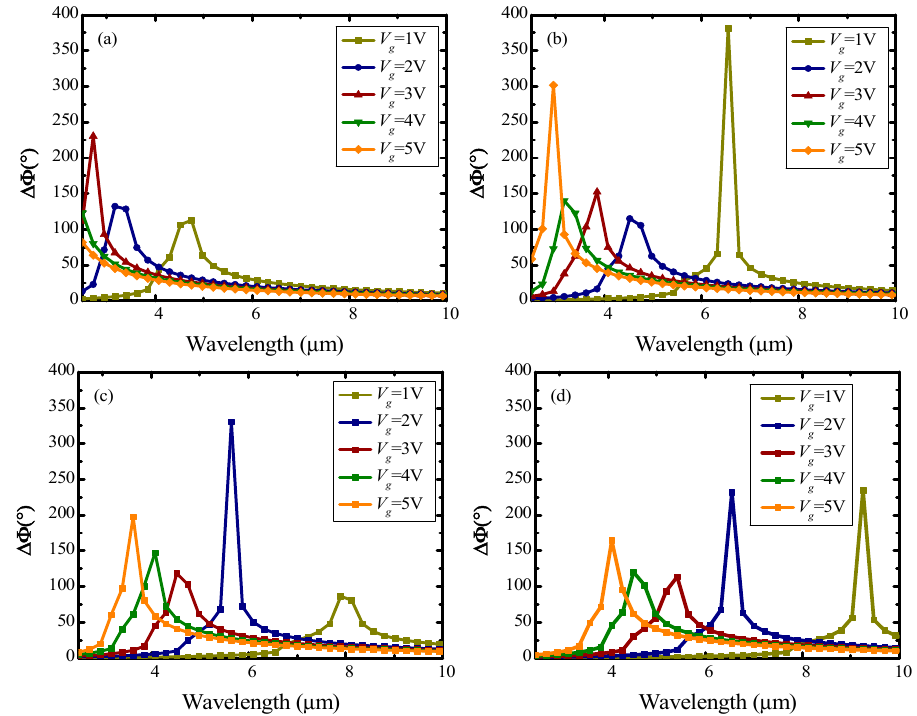
Figure 3. Dependence of phase shift on applied voltage and incident wavelengths at different HfAlO x dielectric thickness: ( a ) d = 50 nm; ( b ) d = 100 nm; ( c ) d = 150 nm; ( d ) d = 200 nm.